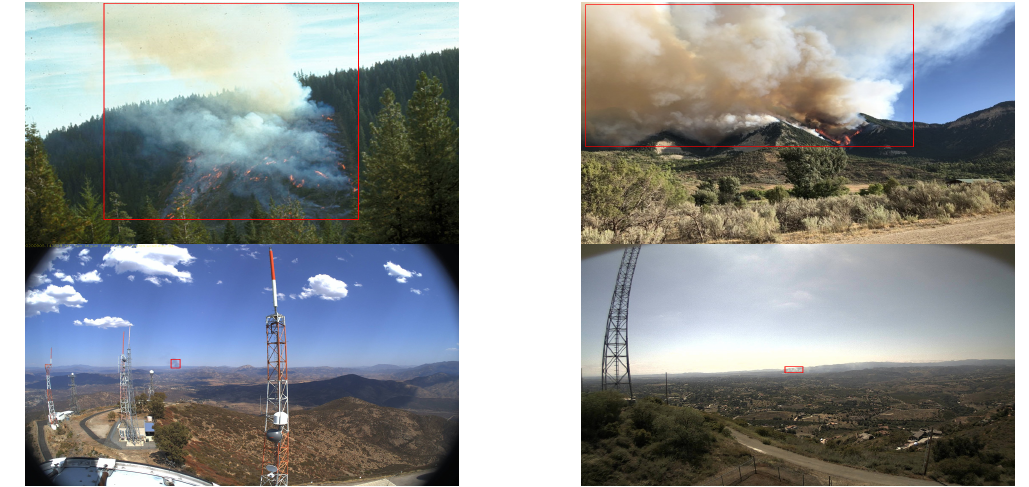
Figure 11. Detection results using our model.